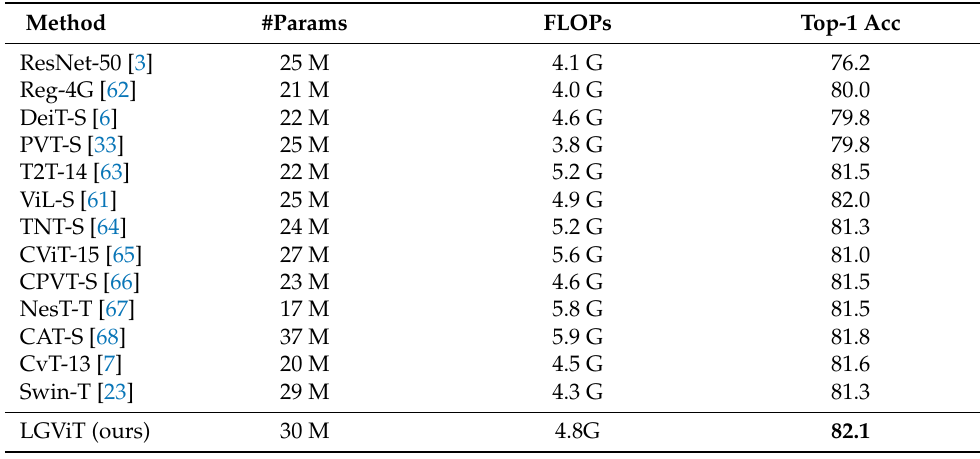
Table 3. Performance comparison of image classification task on the ImageNet-1K dataset for different models. All models are trained and evaluated on 224 × 224